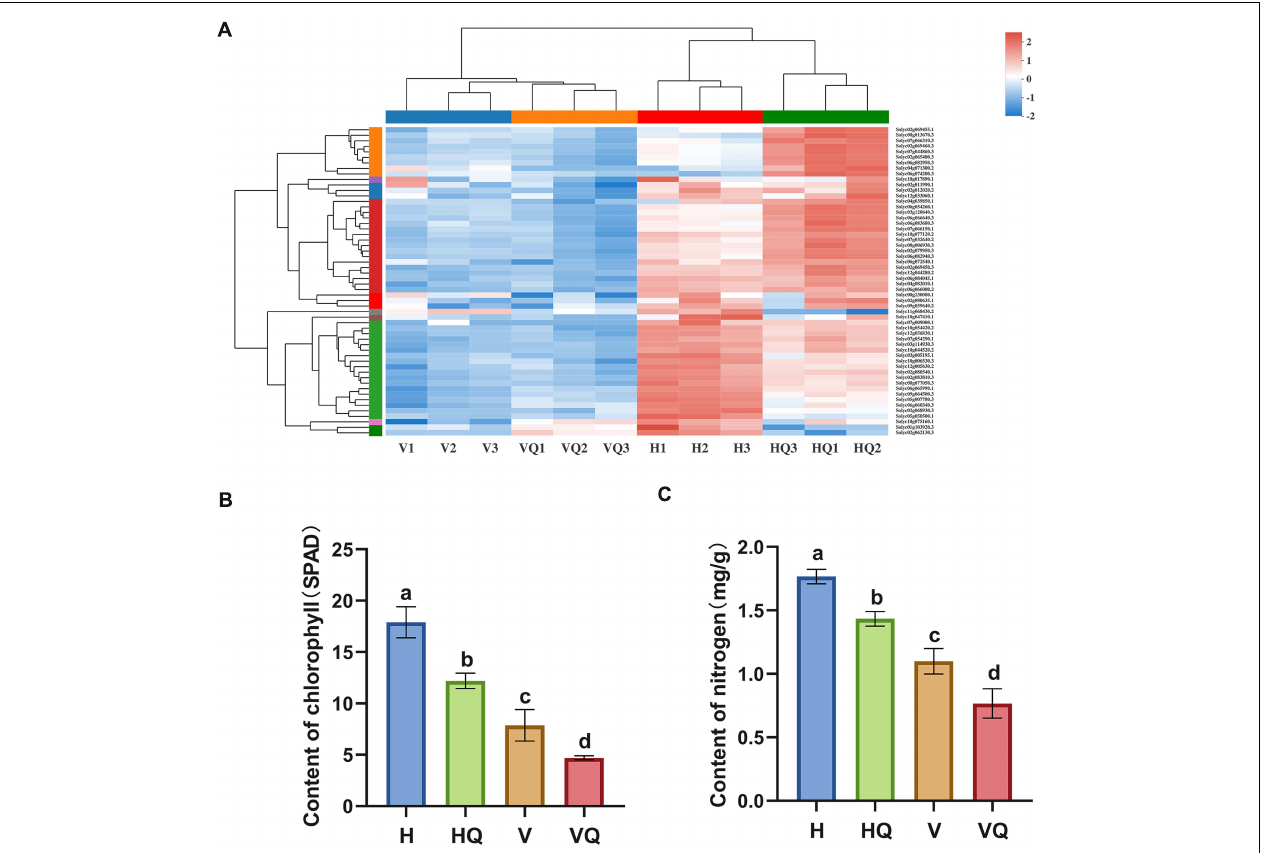
FIGURE 6 | Effects of different treatments on photosynthesis of tomato plants. (A) Differentially expressed photosynthesis genes in tomato plants under different treatments. (B) Chlorophyll content of tomato plants under different treatments. (C) Nitrogen content of tomato plants leaves under different treatments. For each sample, means with different letters are significantly different ( P < 0.05). H, healthy tomato plants. HQ, tomato plants was fed on by healthy B. tabaci for 24 h. V, tomato plants was inoculated with ToCV. VQ, tomato plants with ToCV that were fed on by healthy B. tabaci for 24